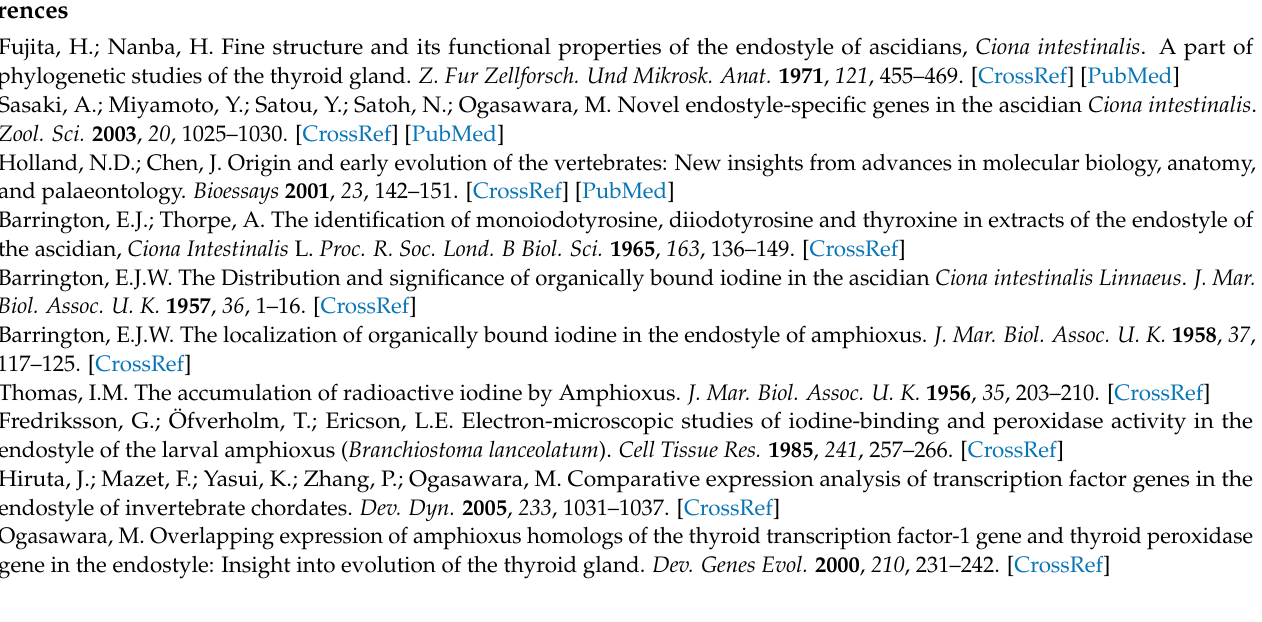
Figure S2: Volcano plot of differential expressed genes among three segments of the endostyle. Figure S3: Transcriptional expression profile of endostyle organ-specific gene (OSG) in ascidian organs. Figure S4: Expression level of endostyle OSGs in zebrafish organs. Figure S5: Expression profile comparison between the endostyle and the pharynx/thymus. Table S1: Organ-specific gene of the endostyle of S. clava . Table S2: Danio expression table for expression similarity ratio. Table S3: Organ transcriptional profile comparison. Table S4: Human tissue enriched gene expression in